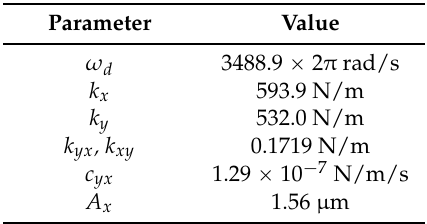
Table 1. MEMS gyroscope parameter